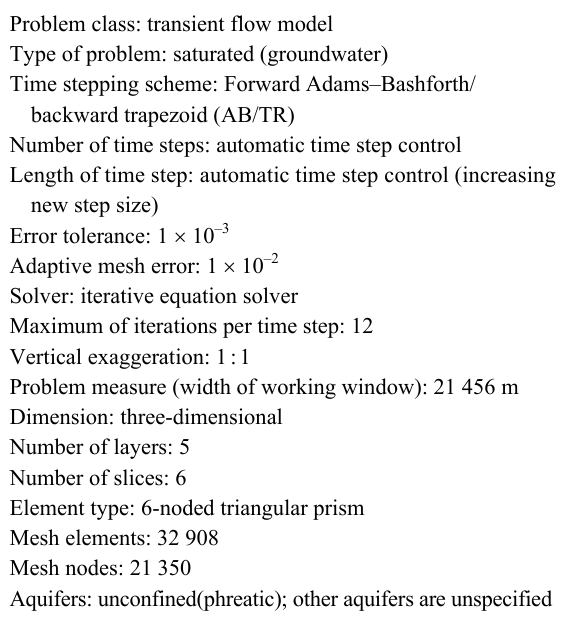
Table 3. Features of the numerical model FEFLOW 5.0 for the Č edasai